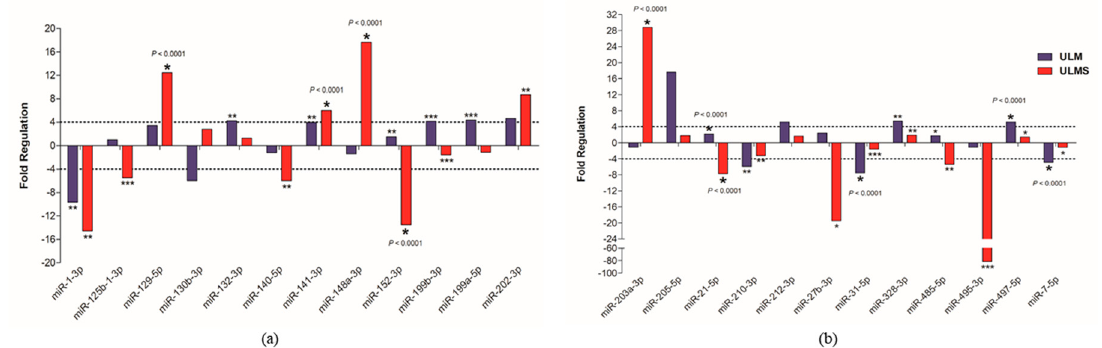
Figure 4. Analysis of 24 differentially expressed miRNAs. ( a , b ) Expression levels of cell lines and MM tissue, with the MM cell used as reference (cut-off +4 and − 4). Student’s t -test; * p < 0.05, ** p < 0.005, and *** p < 0.0005 (the error bars were not provided by software).